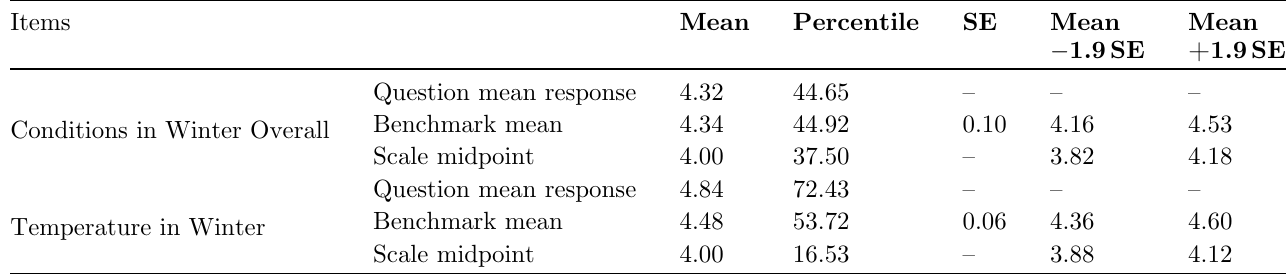
Table 4. Evaluation benchmark set of conditions in winter.